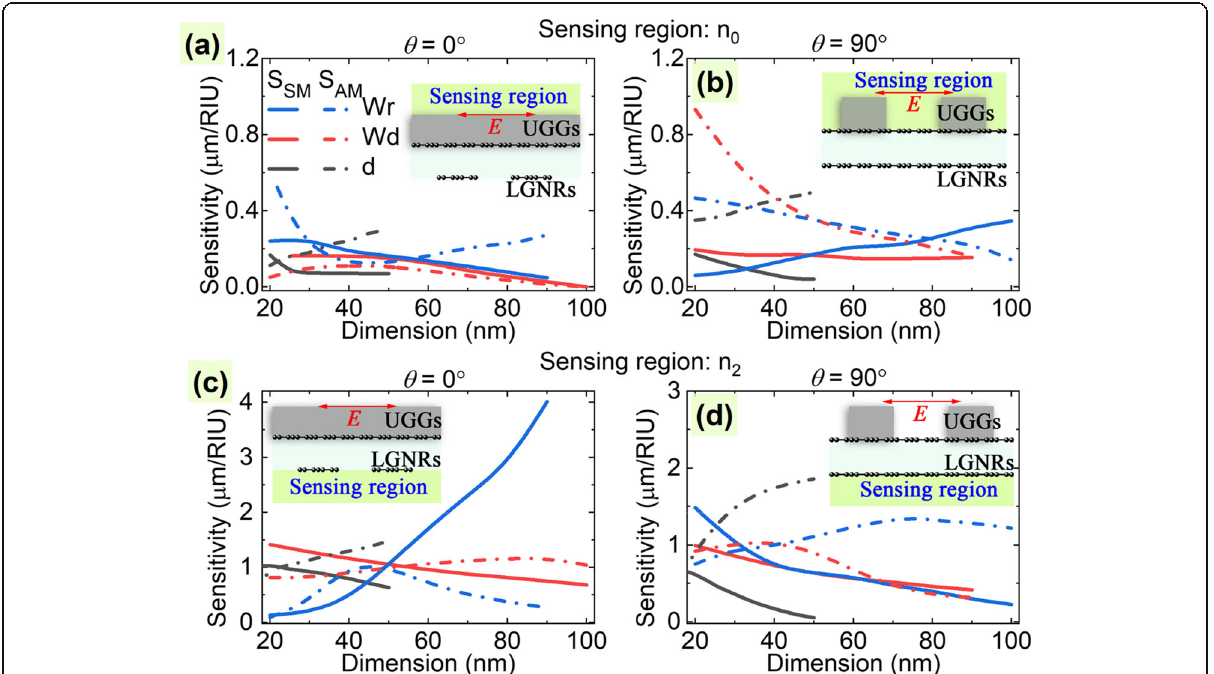
Fig. 5 Refractive index sensitivities of the symmetric mode (S SM , solid lines) and antisymmetric mode (S AM , dash-dotted lines) in the sensing regions of n 0 ( a , b ) and n 2 ( c , d ) as functions of the ribbon width W r of LGNRs, the DG width W d of UGGs, and the separation distance d between the two graphene layers at polarization angles of θ = 0° ( a , c ) and 90° ( b , d ), respectively. The inserts show the location of the sensing